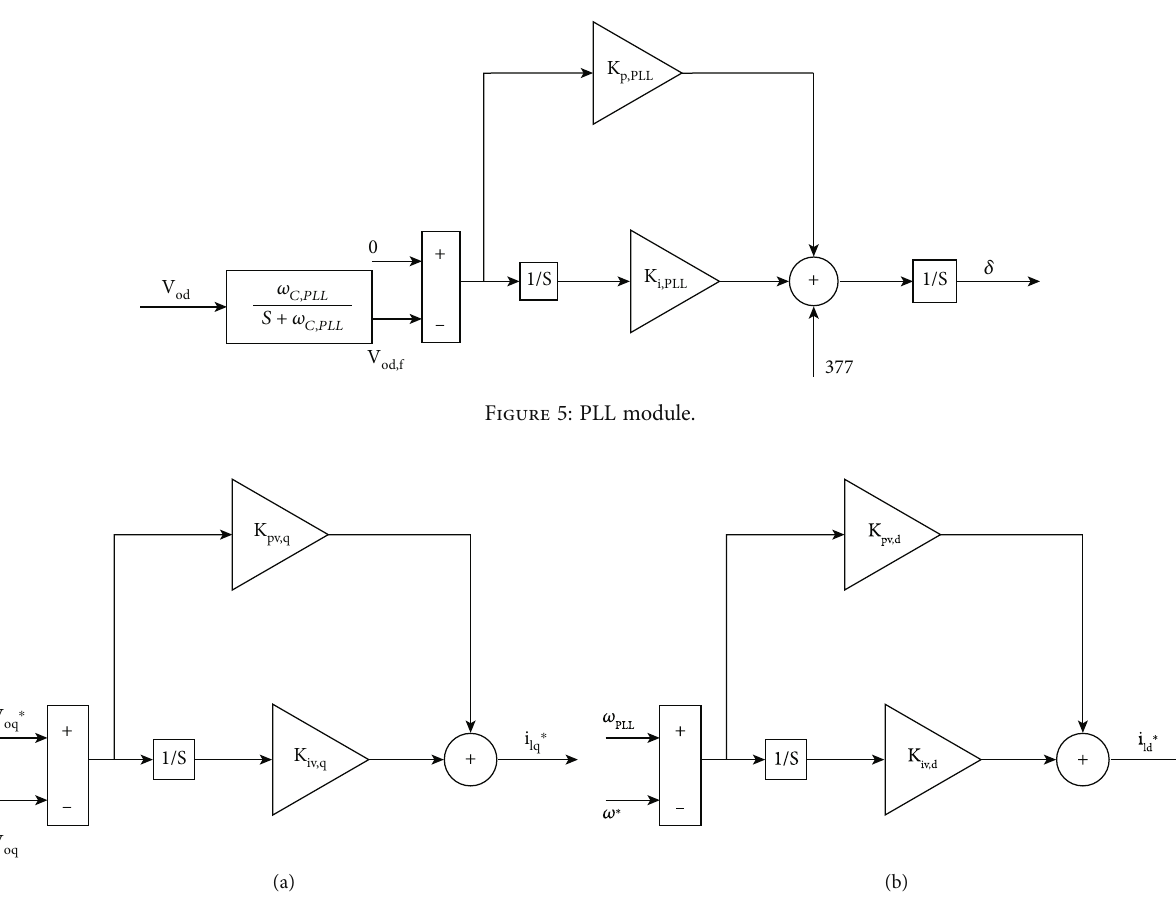
Figure 6: Voltage controller (a), quadrature axis current reference, and (b) direct axis current